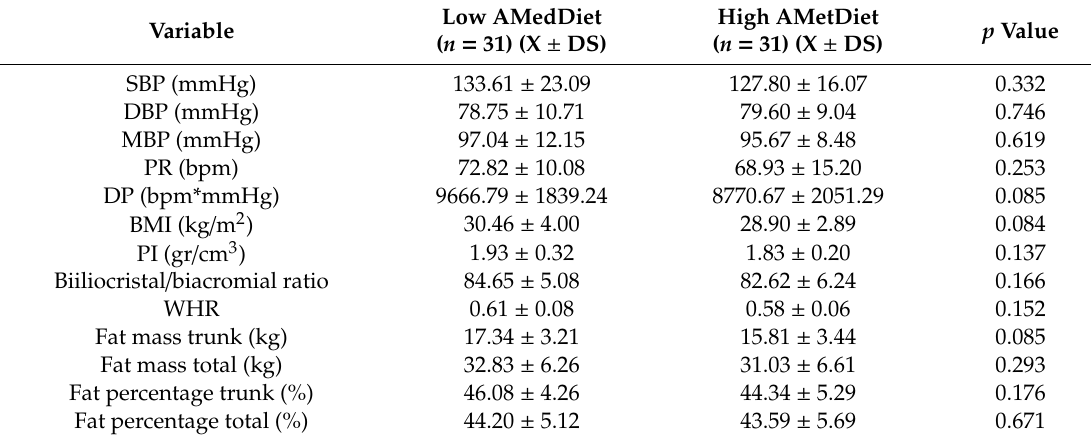
Table 3 report the result of cardiovascular, proportionality, and body composition according to di ff erence is no significate. Table 3. Cardiovascular, proportionality, and body composition variables according to adherence to the Mediterranean diet